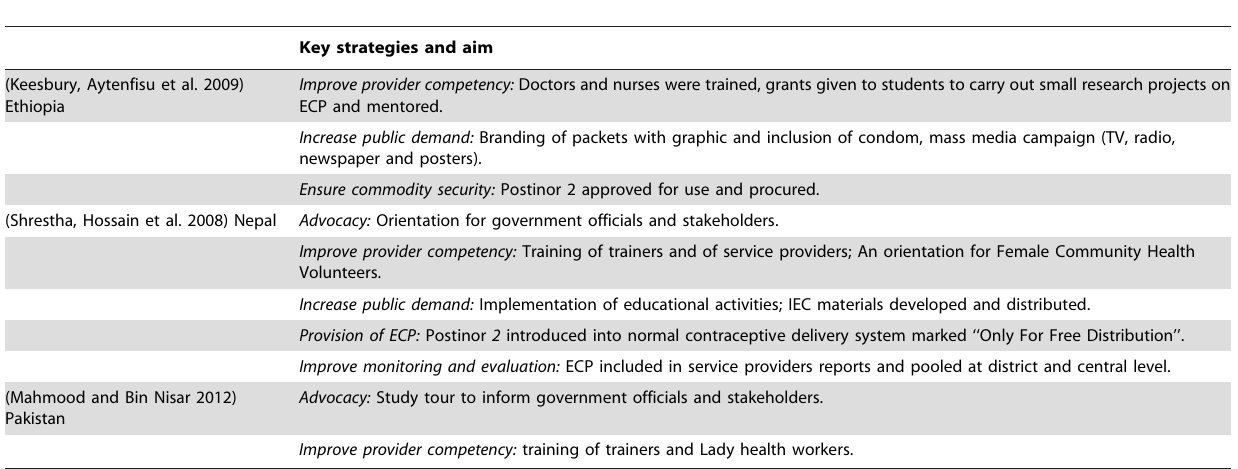
Key strategies and